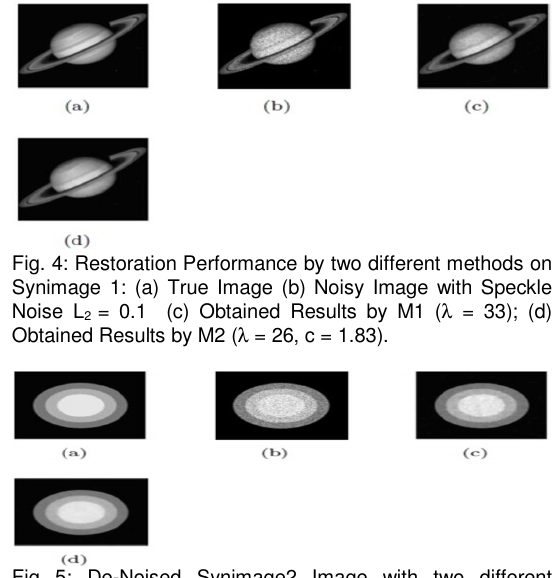
Table 2: The PSNR values, computational time, and iterative numbers of M2 are compared with M1. The computational time is Image Size